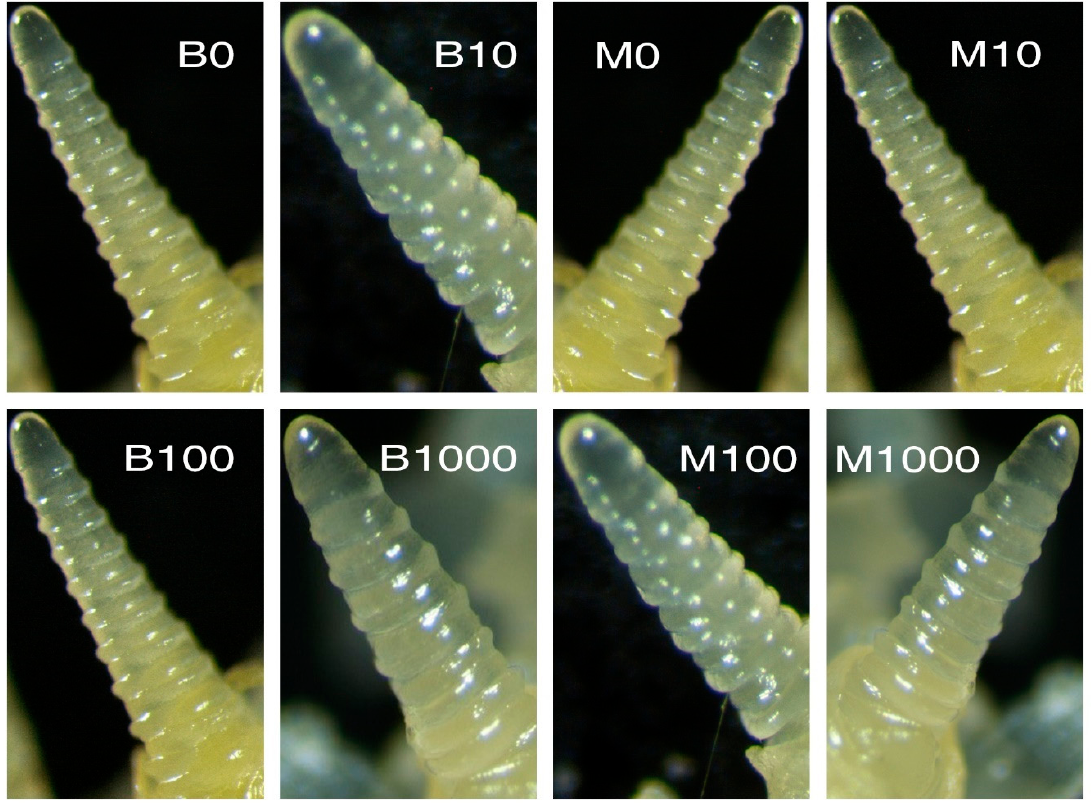
Figure 4. The growing point in various concentrations of GA 3 in the varieties after 60 days of growth. Varieties: Bezostaya (B), left panel, and Mironovskaya (M), right panel. Concentrations of GA 3 : 0, 10, 100 a 1000 mg L − 1 ; Phenological stage: prolonged single ridge.